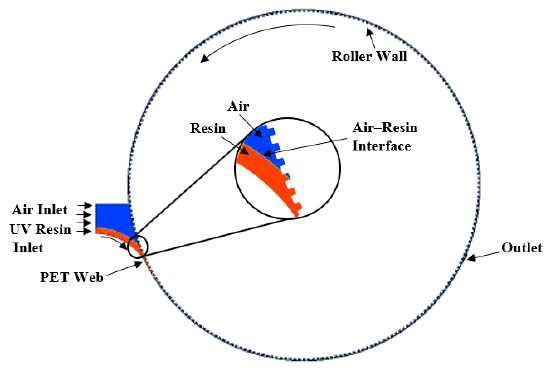
Figure 3. Two-dimensional multiphase model based on a single zone with open-channel boundary conditions and magnified view of the air–resin interface with direct contact of resin with the roller mold. Table 1. Numerical simulation parameters.